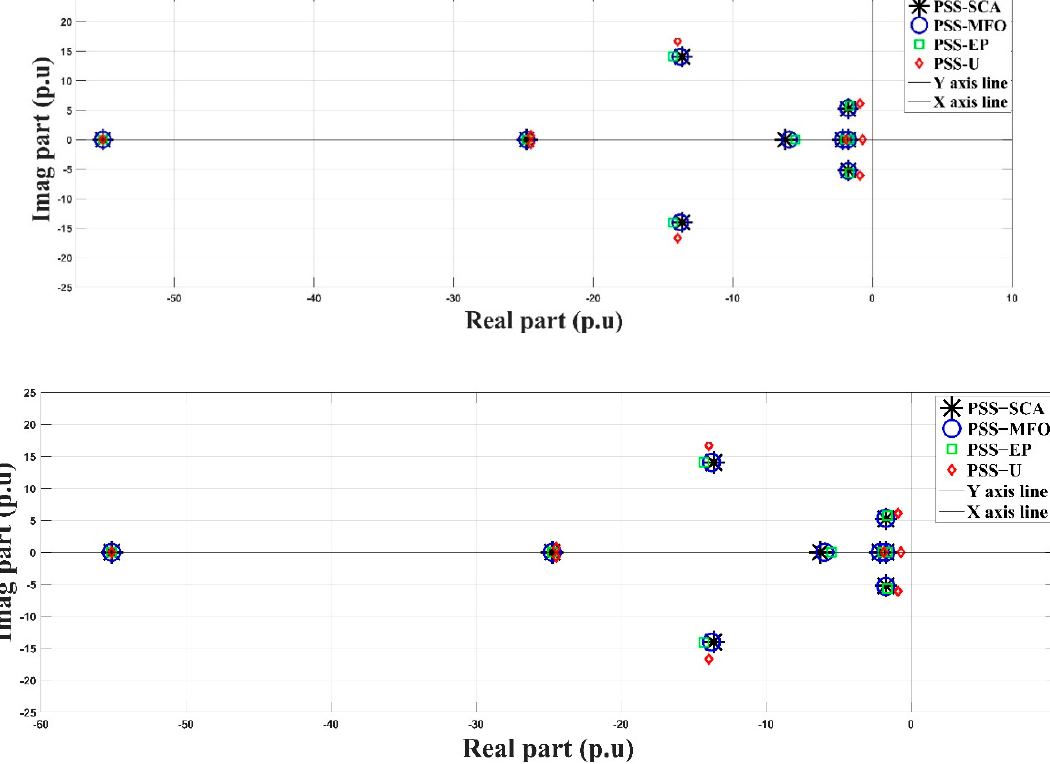
All eigenvalues are on the negative side of the complex s-plane, showing the stable